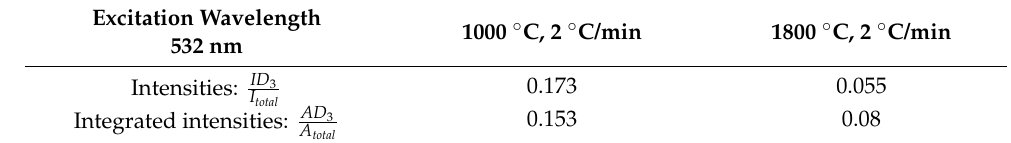
Table 5. Intensity ratios obtained using the 532-nm excitation wavelength.